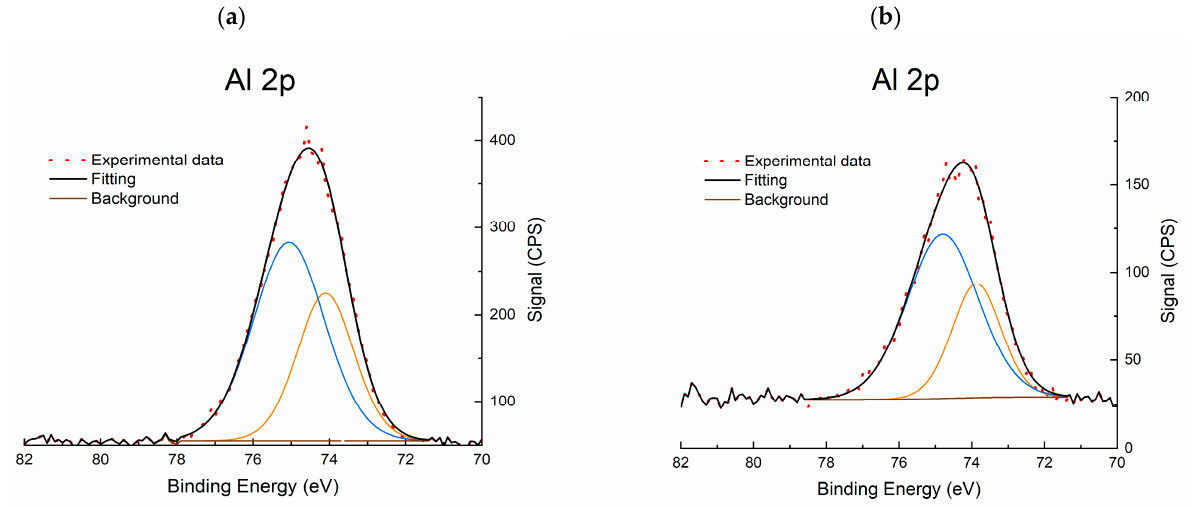
Figure 7. Al 2p XPS region of: ( a ) red(400 °C)-Pd/ γ -Al 2 O 3 and ( b ) red(600 °C)-Pd/ γ -Al 2 O 3 .